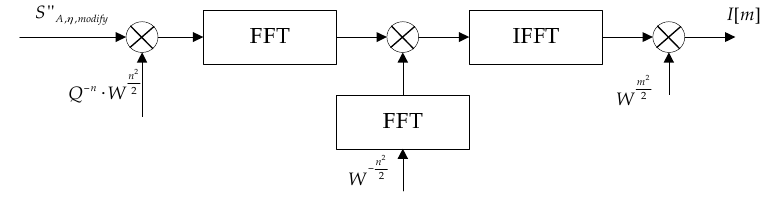
Figure 8. Implementation of the chirp-z transform.